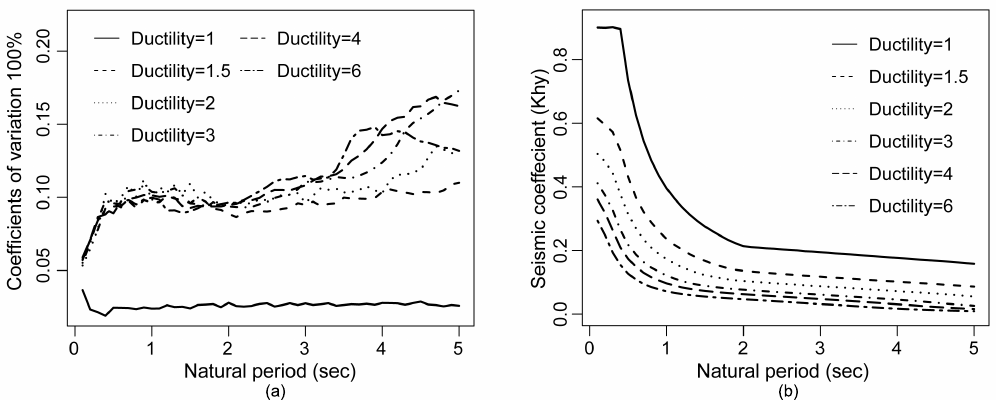
Figure 12. For ductility values of 1, 1.5, 2, 3, 4, and 6 ( a ) Coefficients of variation and ( b ) Mean of YSC demand spectra.